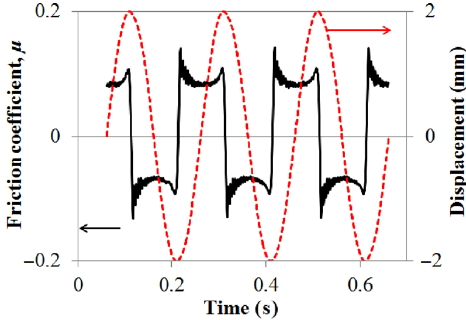
Fig. 1 Example of dynamic friction